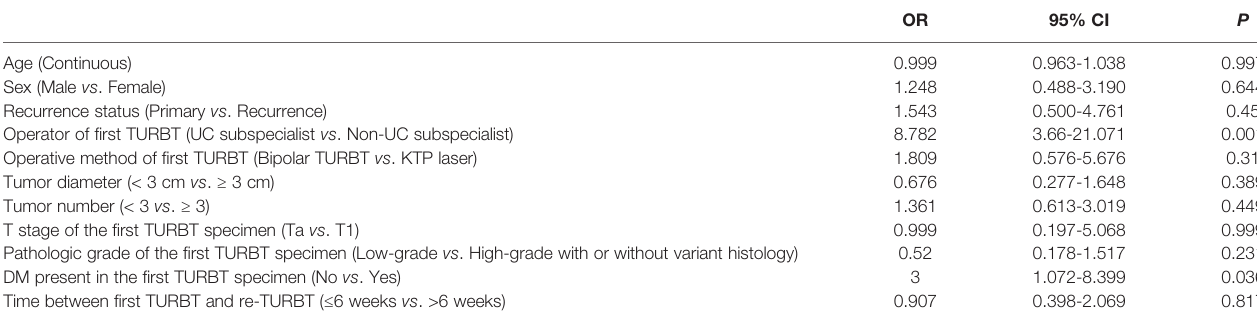
TABLE 3 | Logistic regression analyses of the association between residual tumor in re-TURBT specimens and clinicopathologic